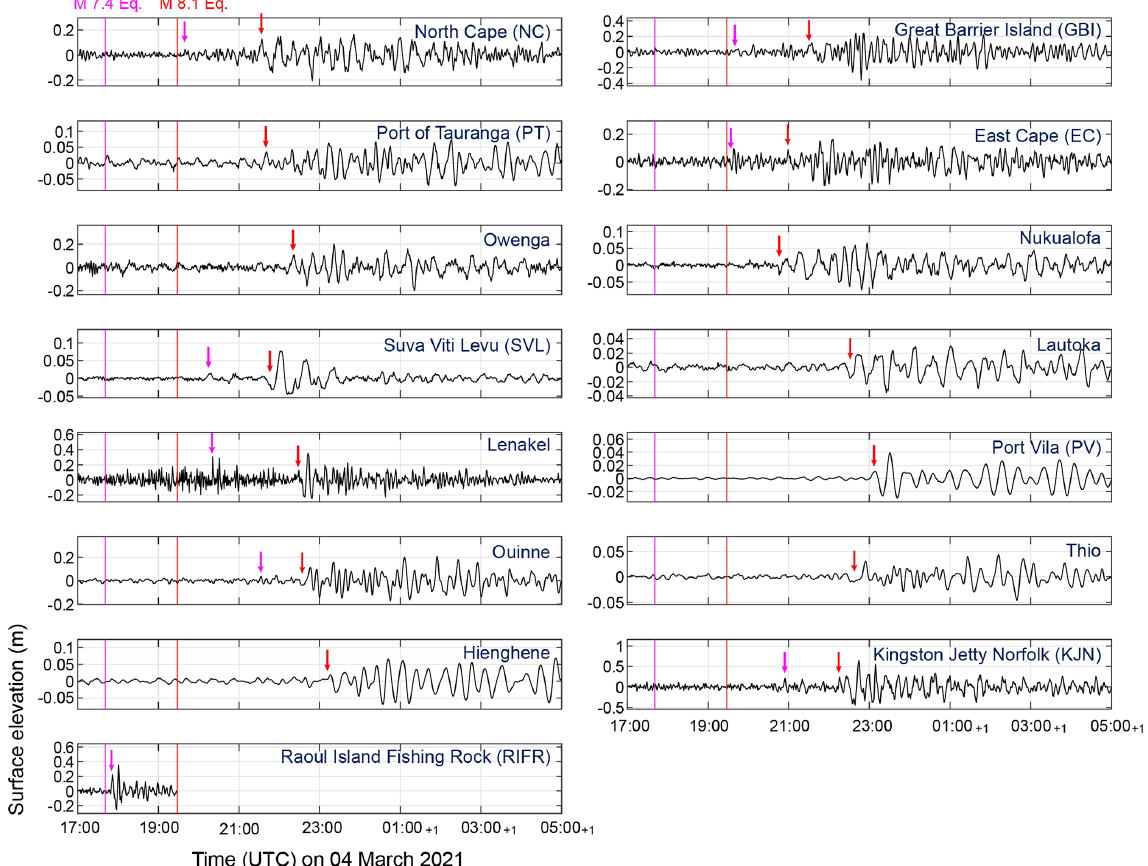
Figure 2. Sea level change recorded by tide gauges showing two tsunamis. The pink and red vertical lines show the origin times of the M w 7.4 and M w 8.1 earthquakes, respectively. The arrival times of the first and second tsunamis are marked by pink and red arrows, respec-